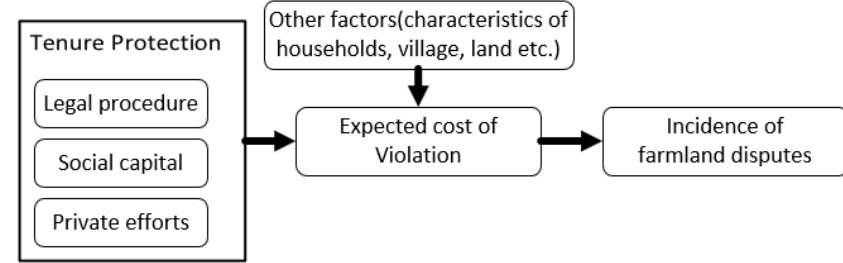
Figure 1. Framework for the determinants of farmland disputes.